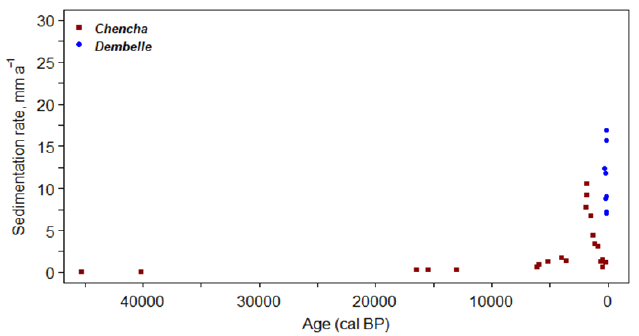
Figure 9. Changing mean floodplain sedimentation rates in Chencha and Dembelle from 46,000 to 0 cal BP based on 30 radiocarbon data.